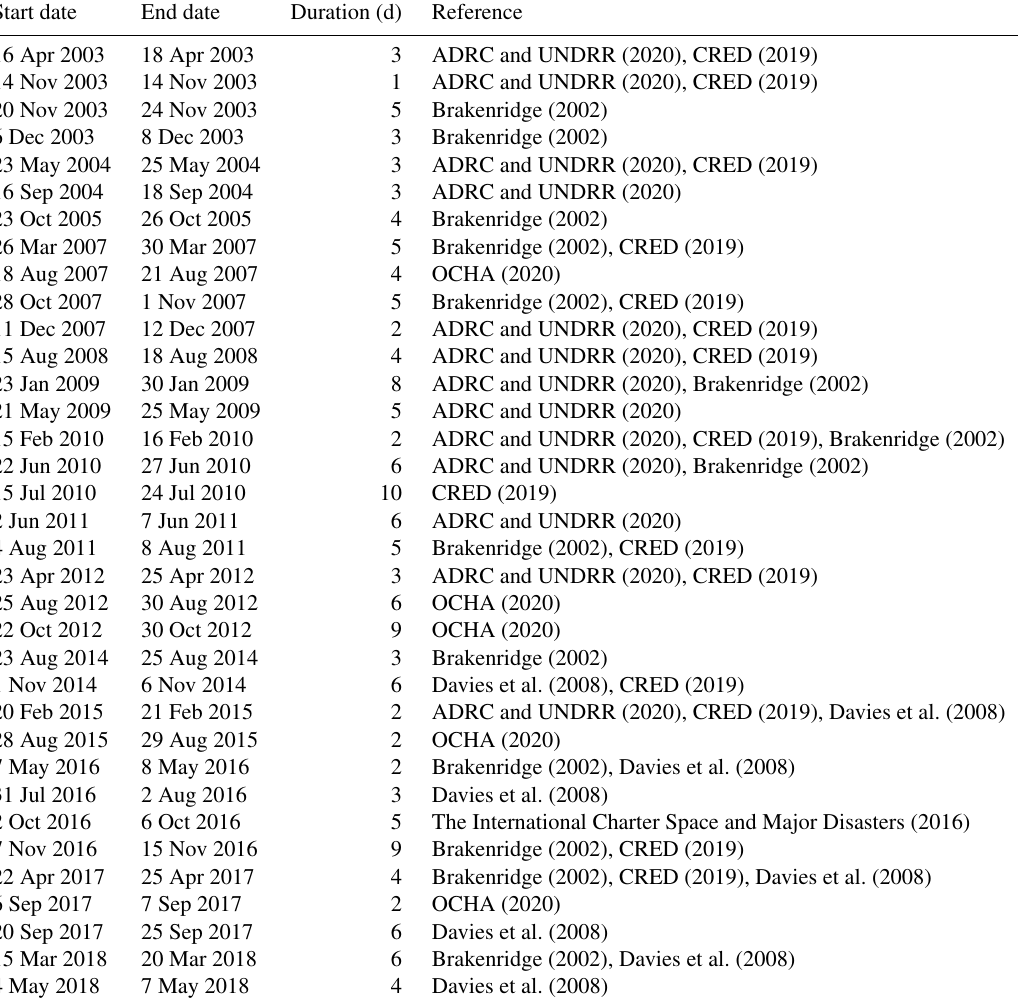
Table A1. Past flood events in the Dominican Republic over the period from 2000 to 2019.